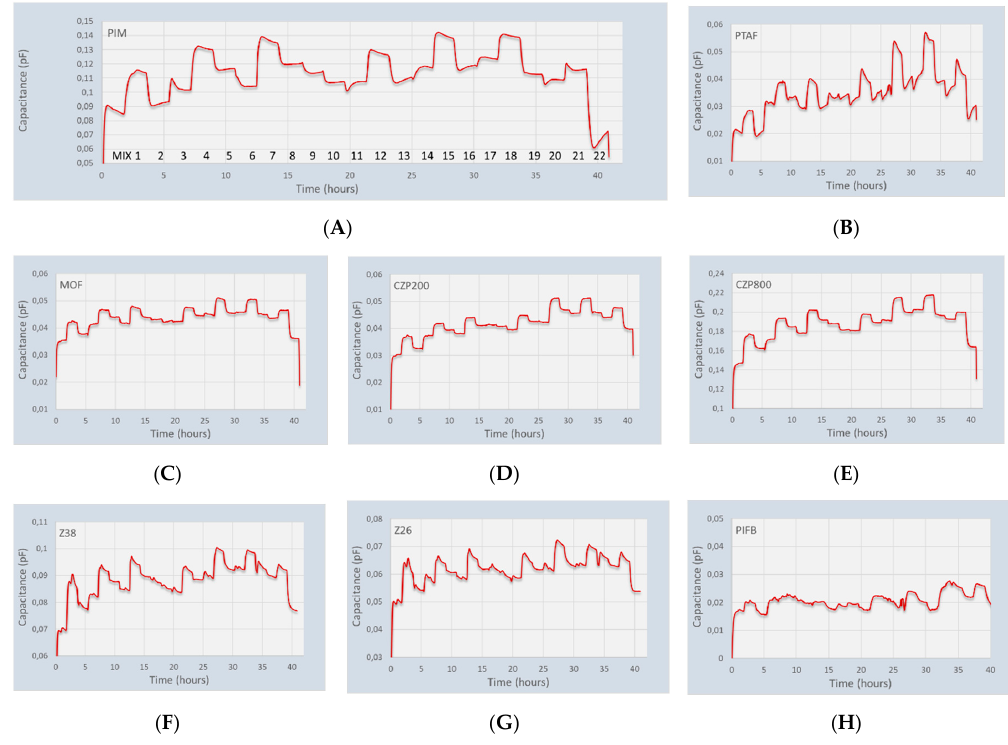
Figure 4. Traces of eight sensing chips when exposed to 22 different gas mixtures at 4 bar(a). ( A ) Polymer of intrinsic microporosity chip; ( B ) Fluorinated polymer chip; ( C ) Metal organic framework ZIF8 chip; ( D ) Zeolite CZP200 chip; ( E ) Zeolite CZP800 chip; ( F ) Zeolite Z38 chip; ( G ) Zeolite Z26 chip; ( H ) Fluorinated polyimide chip.